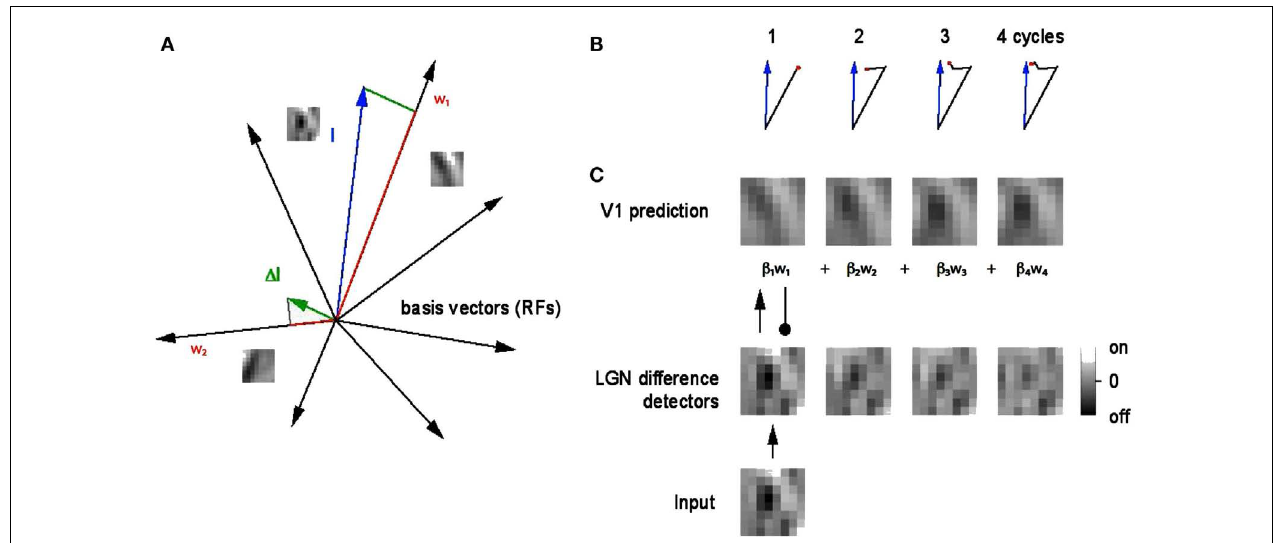
process repeats. A very small number of repetitions produces an accurate representation. (B) Four steps in the vector approximation. (C) The evolution of the approximation in pictorial terms.The green vector is also the basis for the learning algorithm. After each vector is chosen, it is moved closer to the input by adding the residual into its synaptic weight vector.The weight vectors are normalized to unity, reflecting a constraint that limits the total strength of the